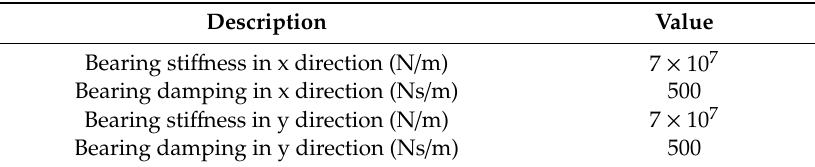
Table 4. Rolling-element bearing specifications of the rotor model.